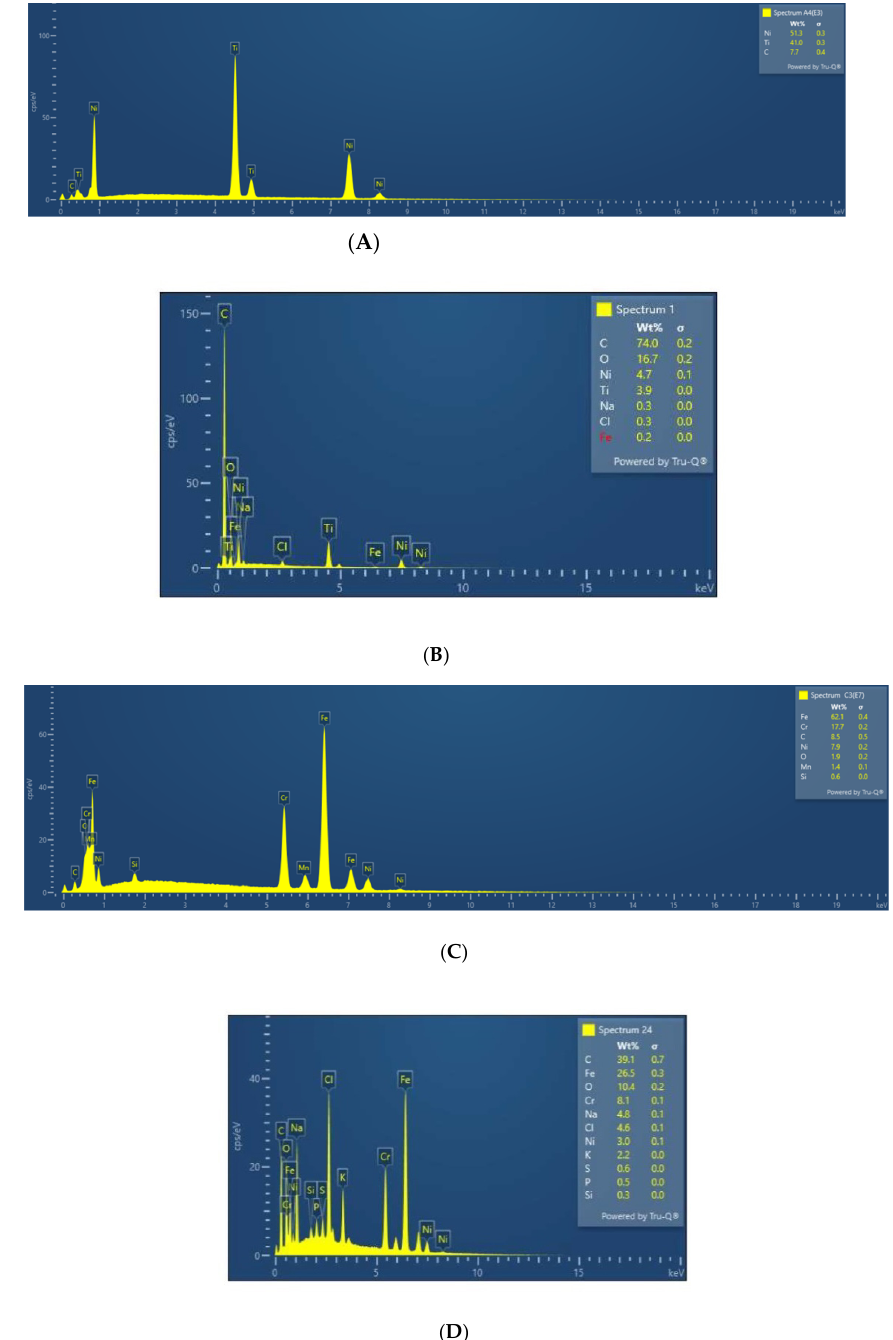
Figure 4. ( A ) NiTi before immersion; ( B ) NiTi after immersion; ( C ) Stainless steel before immersion; ( D ) Stainless steel after immersion.